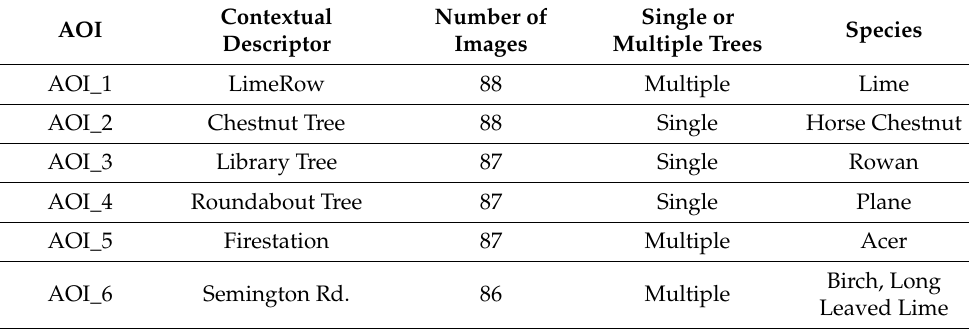
Table 1. Description of Area of